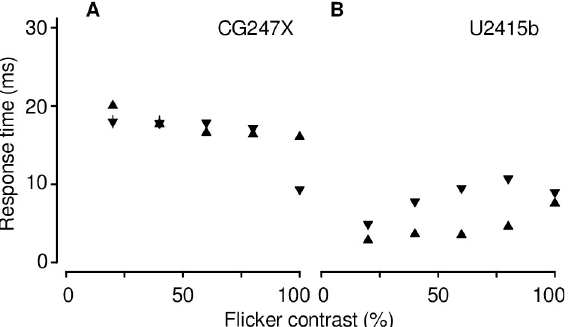
Fig 7. Response times of mean-modulated flicker. Overall, CG247X ( A ) rise (upward triangles) and fall (downward triangles) times were greater than U2415b ( B ) rise and fall times. With the exception of 100% contrast, CG247X rise and fall times were approximately equal, indicating its potential suitability for presenting mean-modulated flicker. Each symbol represents the mean of 10 measurements. Error bars, where not obscured by symbols, mark the full range (minimum to maximum) of the 10